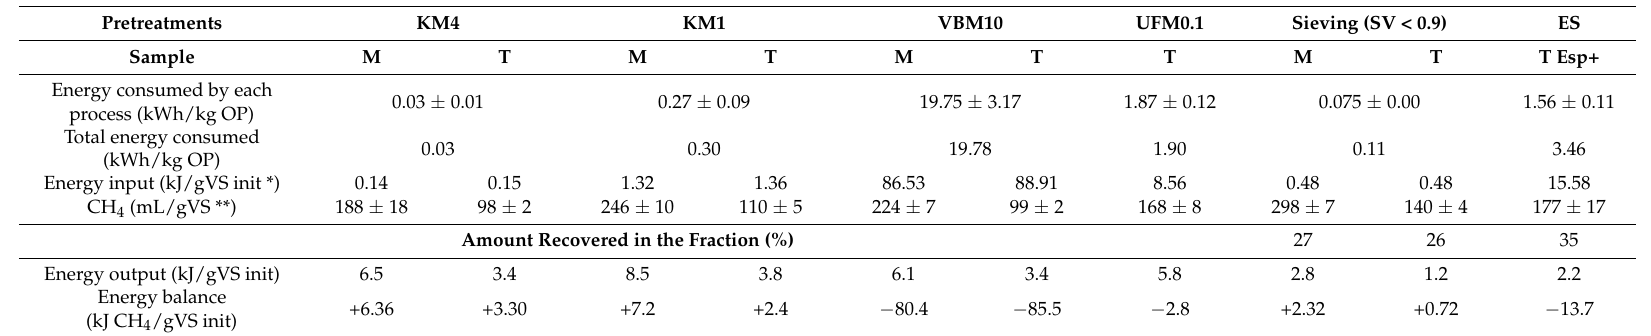
Table 3. Energy balance and dry fractionation